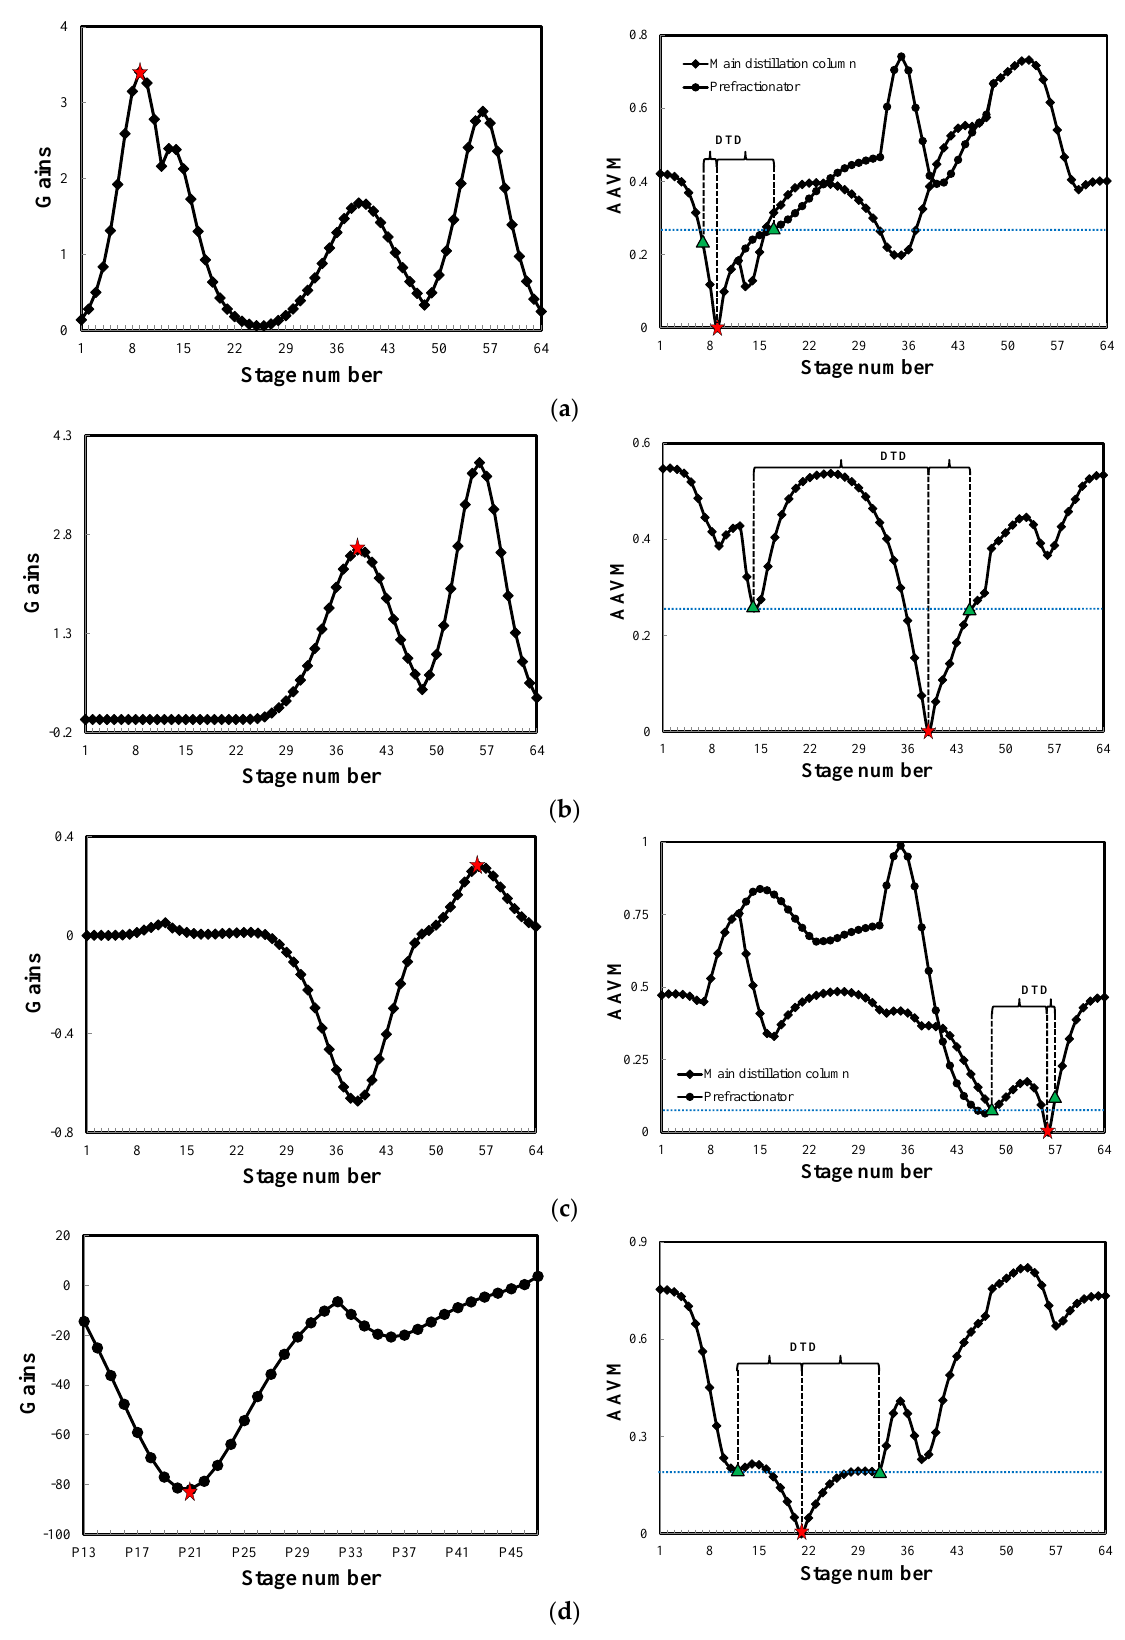
Figure 4. Results of the sensitivity analysis and AAVM analysis (Example I): ( a ) top control loop; ( b ) sidestream control loop; ( c ) bottom control loop; ( d ) prefractionator control loop. (Red pentagram: sensitive stage; green triangle: reference stage).